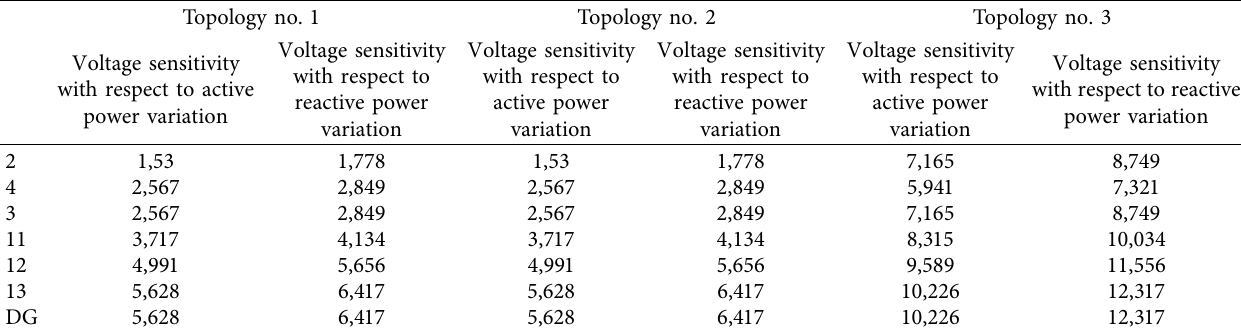
Table 1: Voltage sensitivity analysis with respect to the variations of active and reactive power variations. Topology no. 1 Topology no. 2 Topology no.